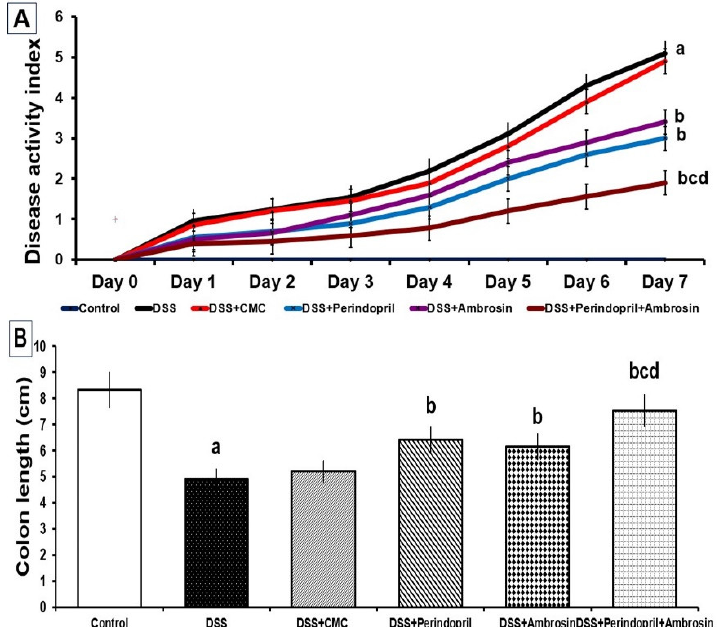
Figure 1. Perindopril with or without ambrosin mitigated the disease activity index (DAI) ( A ) and restored the colon length ( B ) in mice treated with dextran sulfate sodium (DSS) (Mean ± SD); where “a” denotes significant vs. the control group ( p -value less than 0.05); “b” denotes significant vs. DSS group ( p -value less than 0.05); “c” denotes significant vs. DSS + perindopril group ( p -value less than 0.05); “d” denotes significant vs. DSS + ambrosin group ( p -value less than 0.05).